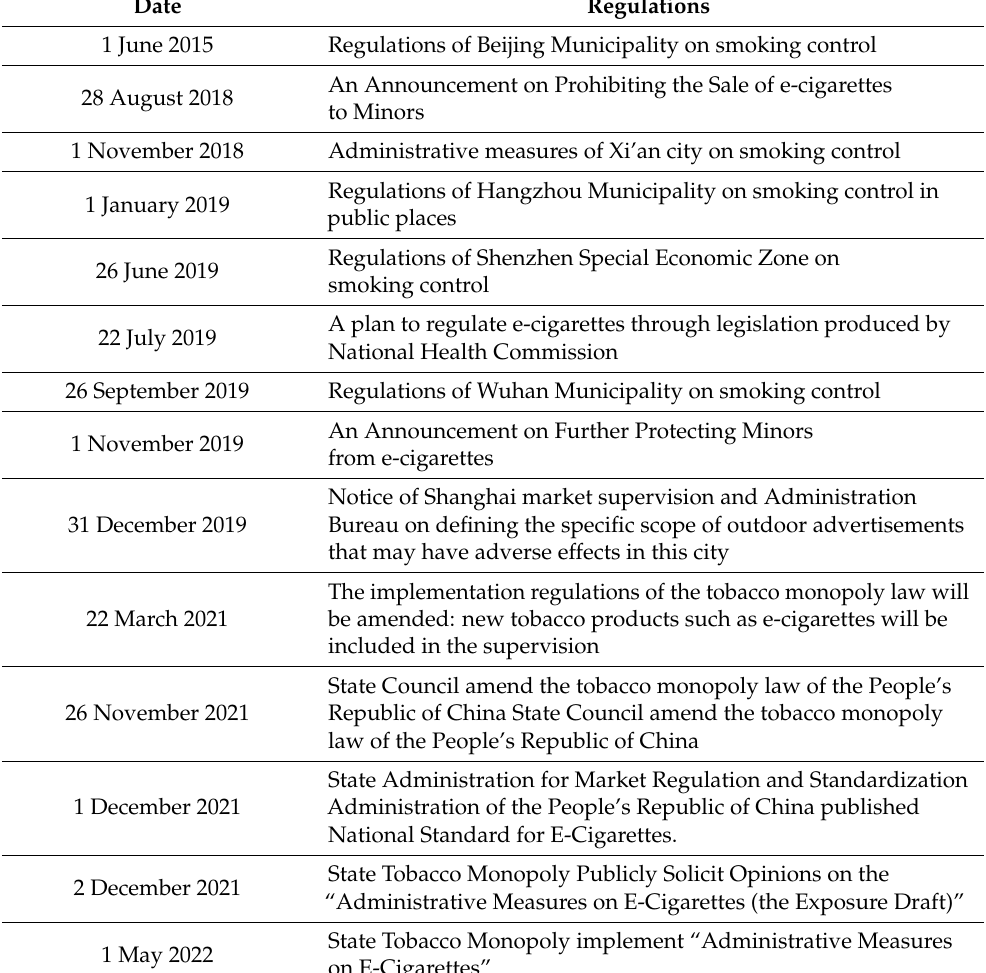
Table 2. Chinese regulations about